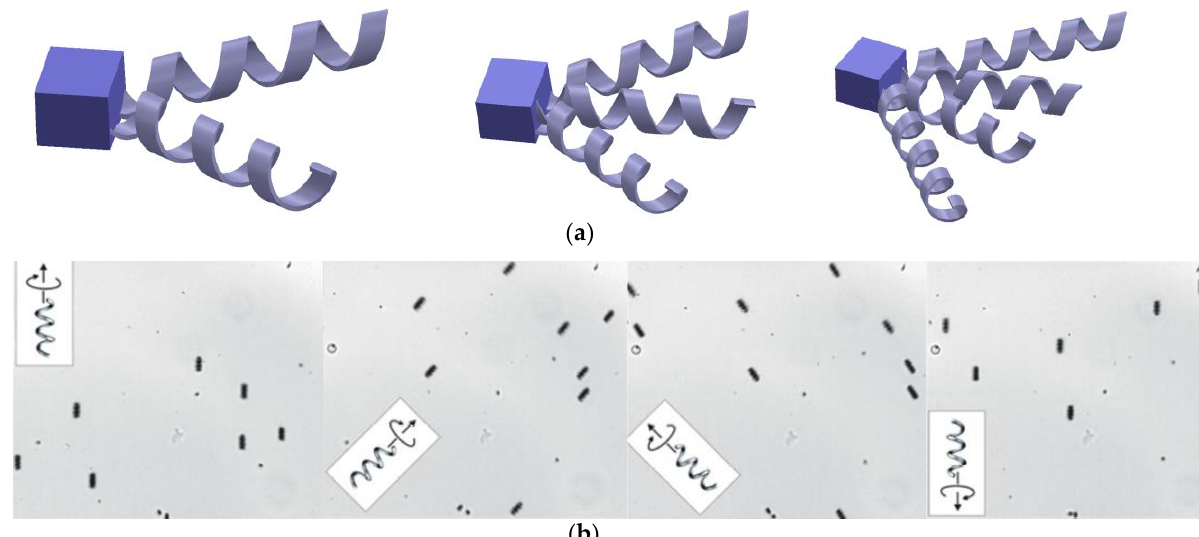
Figure 3. Helical microrobots: ( a ) With multiple flagella; ( b ) swarm of helical microrobots manipu- lated in different directions [63].